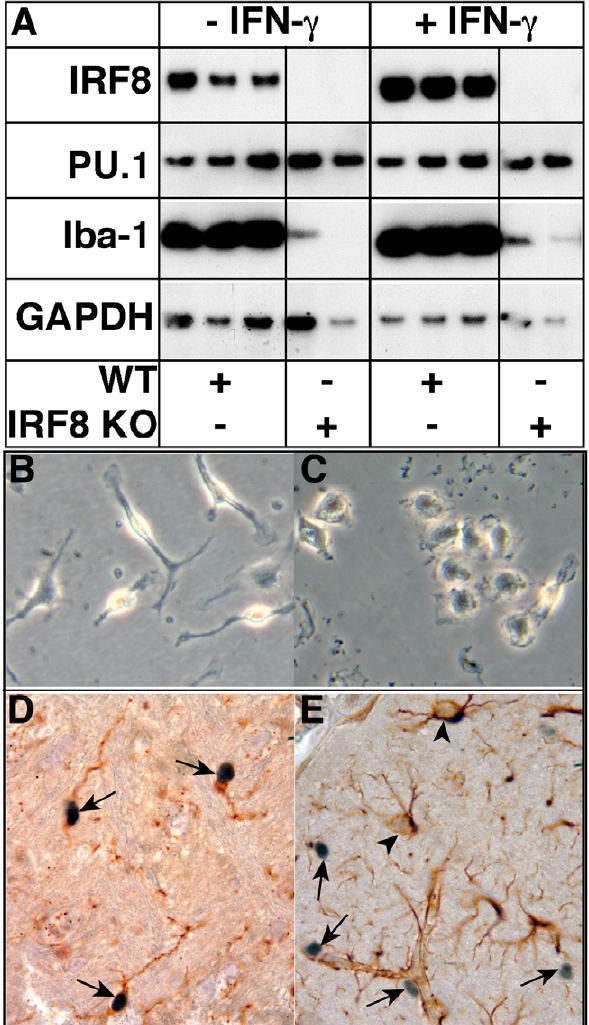
Figure 1. Comparative features of cultured microglia from WT versus IRF8-deficient mice and localization of IRF8 in the brain. Microglial cell cultures were prepared from the brain of neonatal mice as described in the Materials and Methods. Western blot analysis was performed on lysates of WT and IRF8-deficient primary microglia following treatment with (100 U/ml) or without IFN- c for 4 h. GAPDH was used as a loading control (A). Morphological appearance of WT (B) or IRF8-deficient (C) microglia in primary culture (original magnification panels B&C, 400X). Immunohistochemical detection of IRF8 (D & E, arrows) combined with histochemical staing for tomato lectin binding (D) or GFAP immunohistochemistry (E, arrowheads). performed on brain sections from healthy adult mice. IRF8 staining is mostly confined to the nucleus of the cells (original magnification panel D, 1000X).